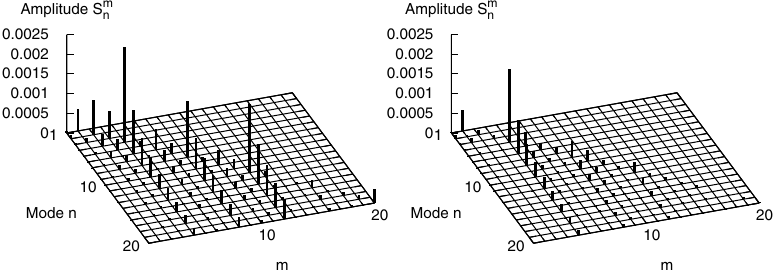
FIG. 6. The energy spectra at the Bragg peak layer (a) for the zero-temperature beam ( r (cid:6) 3 : 73 mm ) and (b) with the beam temperature ( r (cid:6) 3 : 83 mm ) for the Al layer target. The global nonuniformity spectra using the weight w temperature beam and (d) with the beam temperature for the Al layer